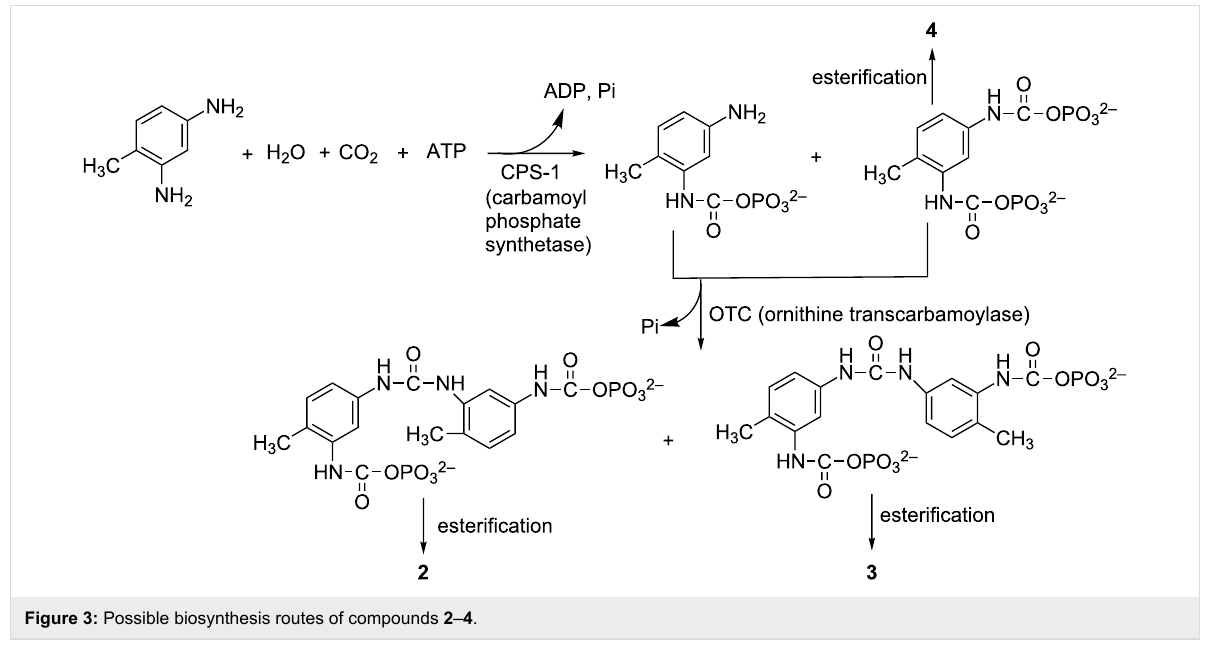
Figure 3: Possible biosynthesis routes of compounds 2 – 4 .